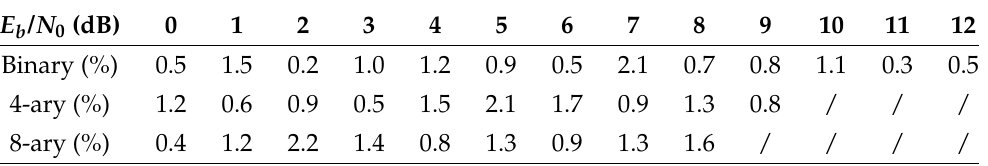
Table 4. The errors between the BER performance and the theoretical results of optimal receiver (100 × 10 5 PPM